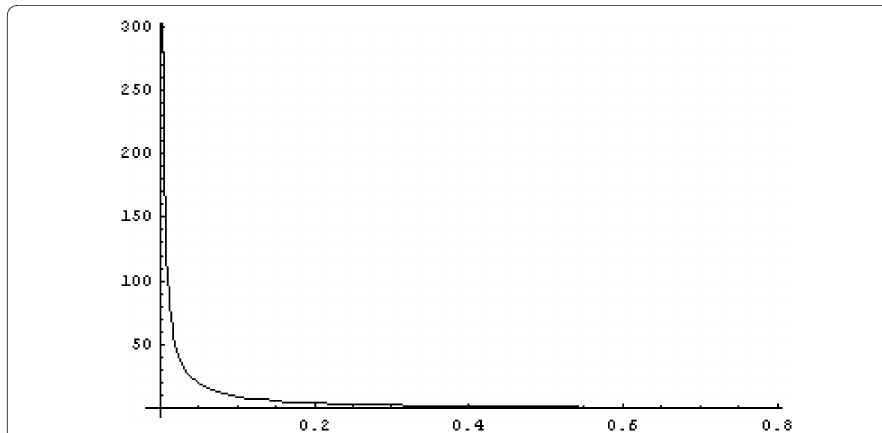
Figure 2 The graph of the function ϕ ∗ , where t ∈ (0, π